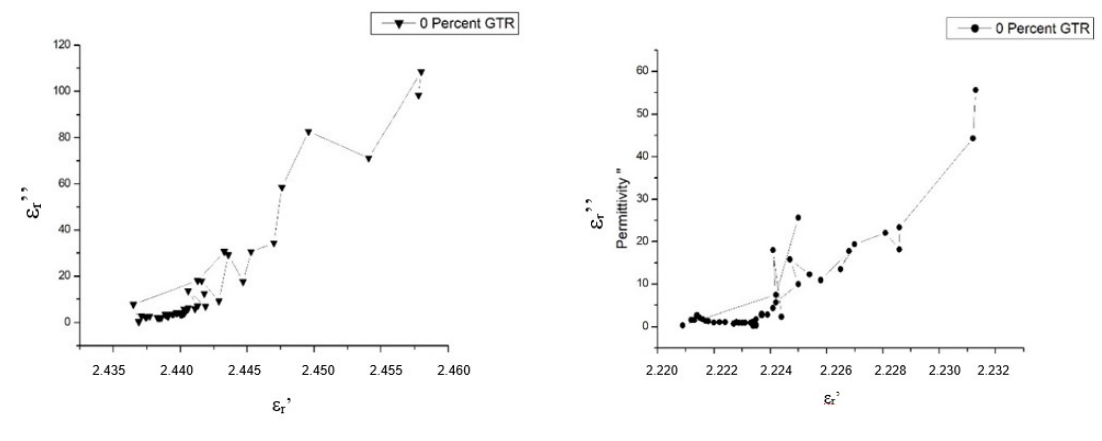
Figure 11. Cole–Cole diagram ( ε′ – ε″ ), of ( a ) HDPE and HDPE + 10–20–40% GTR—Log–Log scale, ( b ) neat HDPE at 50 °C, and ( c ) neat HDPE at 70 °C.